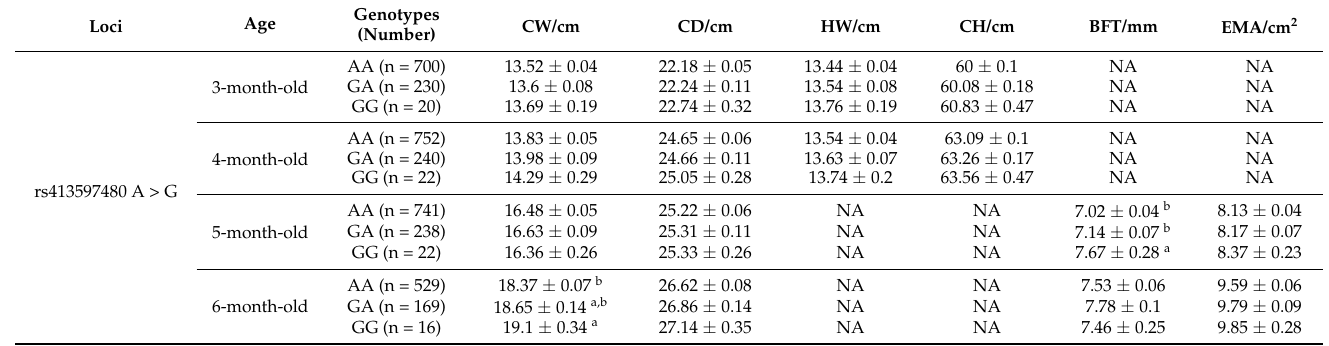
Table 5. Association analysis between the ARNT gene polymorphisms and growth traits (CW, CD, HW, CH, BFT, and EMA) of Hu sheep from 3-month-old to